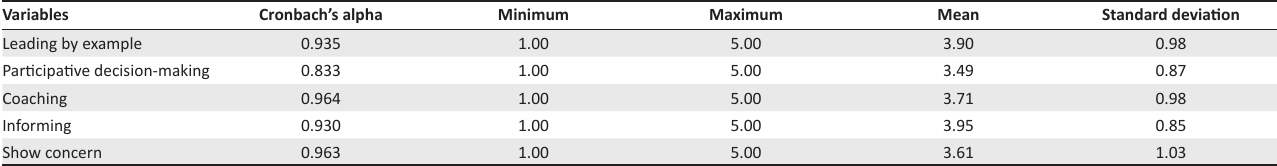
TABLE 4: Reliability, mean and standard deviation of the Empowering Leadership Questionnaire. Variables